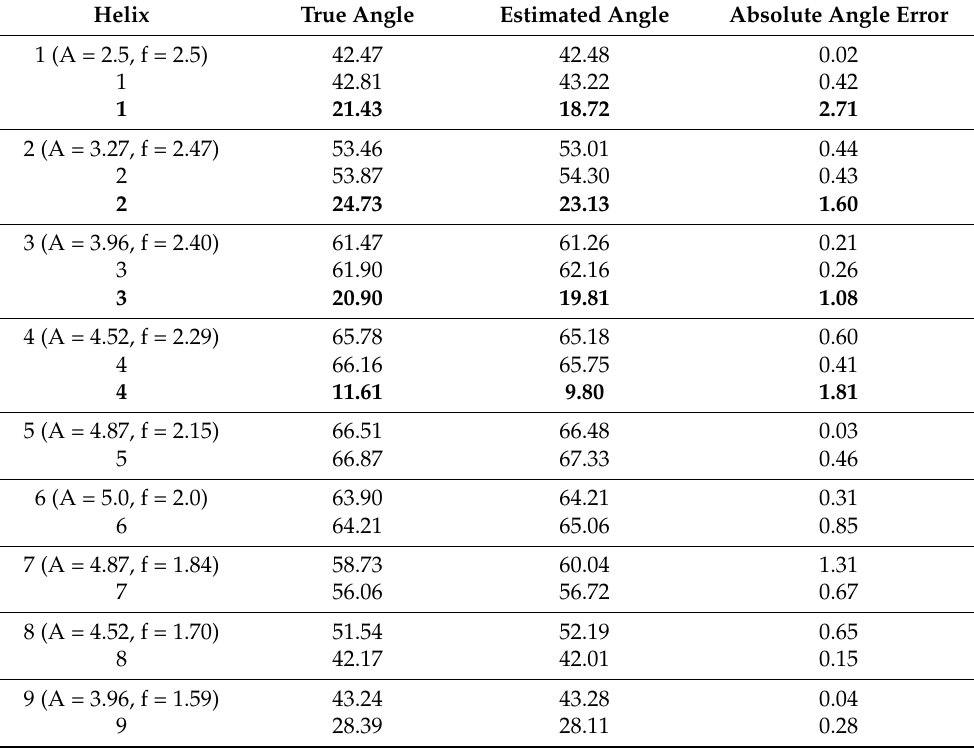
Table 1. Assessed Absolute Angle Error by the specially developed signal-processing procedure on a set of noisy synthetic helixes modelling spine deformations during movement. (The angles computed with one inflexion point at one of the borders are highlighted in